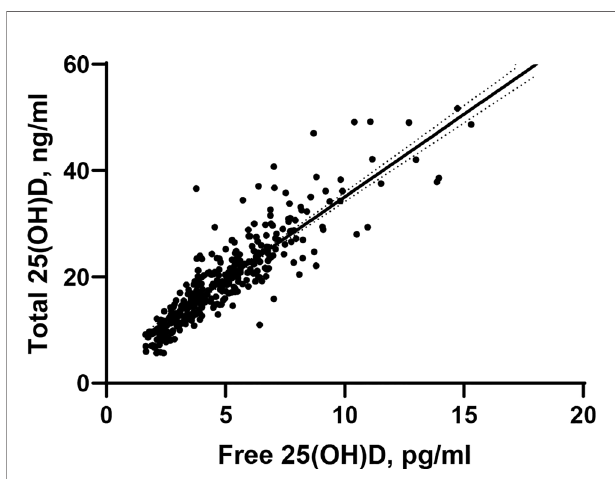
FIGURE 1 | Scatter plots depicting bivariate associations between free 25 (OH) D and total 25(OH)D. rho=0.912, p<0.0001.